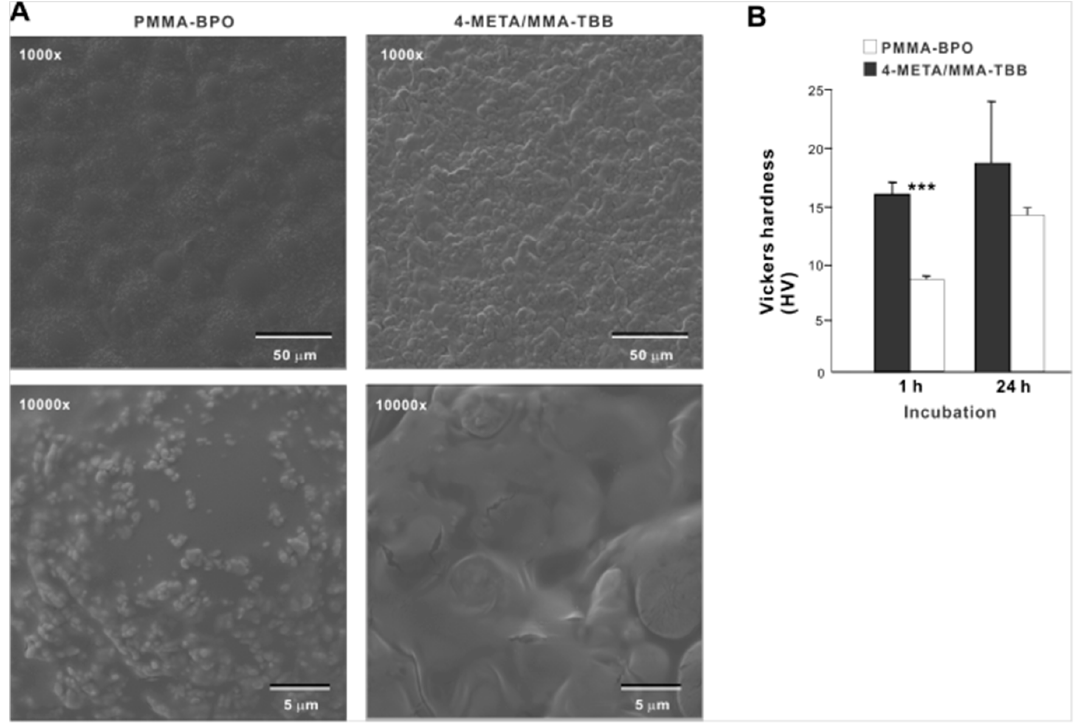
Figure 1. Morphologic and mechanical characterization of polymer materials used in this study. ( A ) SEM images of PMMA-BPO and 4-META/MMA-TBB materials 24 h after mixing polymer and monomer. ( B ) Vickers hardness of the two materials 1 and 24 h after mixing. *** p < 0.001, statistically significant difference between the two materials. PMMA-BPO, poly(methyl methacrylate)–benzoyl peroxide; 4-META, 4-methacryloyloxylethyl trimellitate anhydride; MMA-TBB, methyl methacrylate–tri-n-butyl borane.